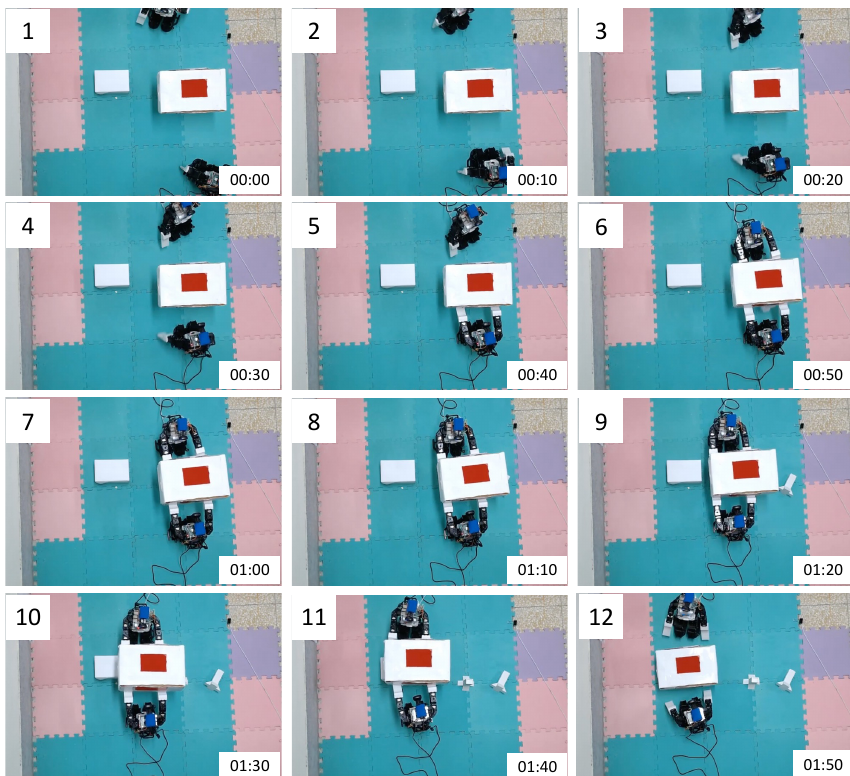
Figure 8. Experimental configuration.